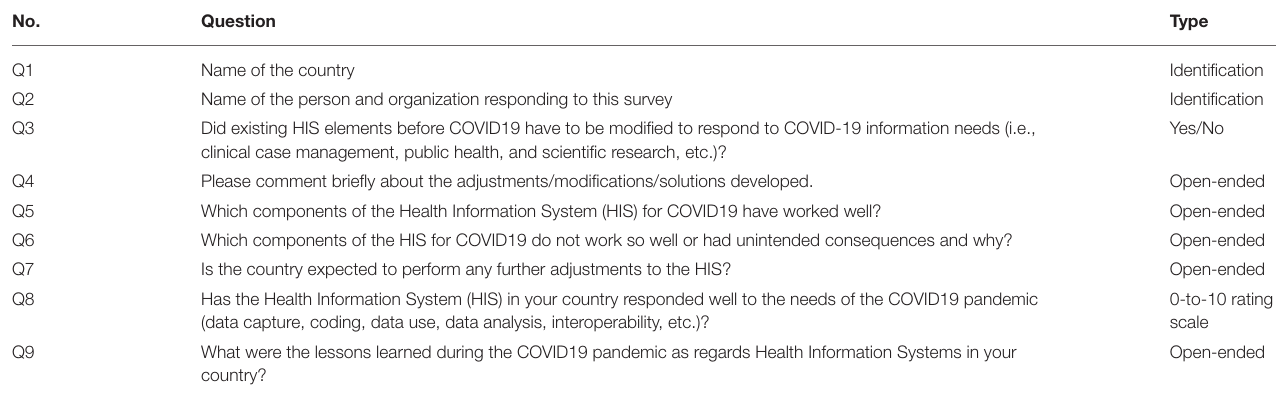
TABLE 1 | Survey questions.